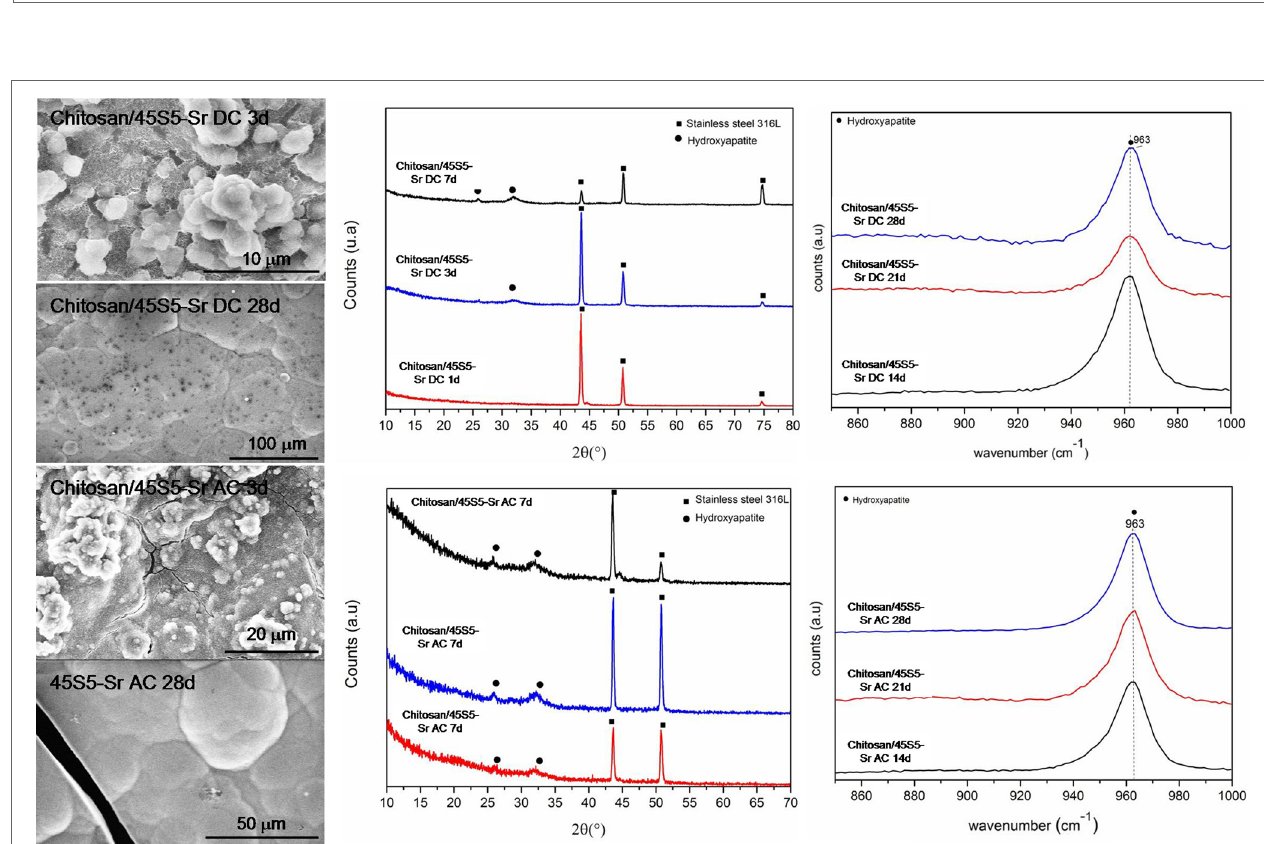
FigUre 10 | seM micrographs of 45s5-Zn-containing coatings after different times of immersion in sBF .